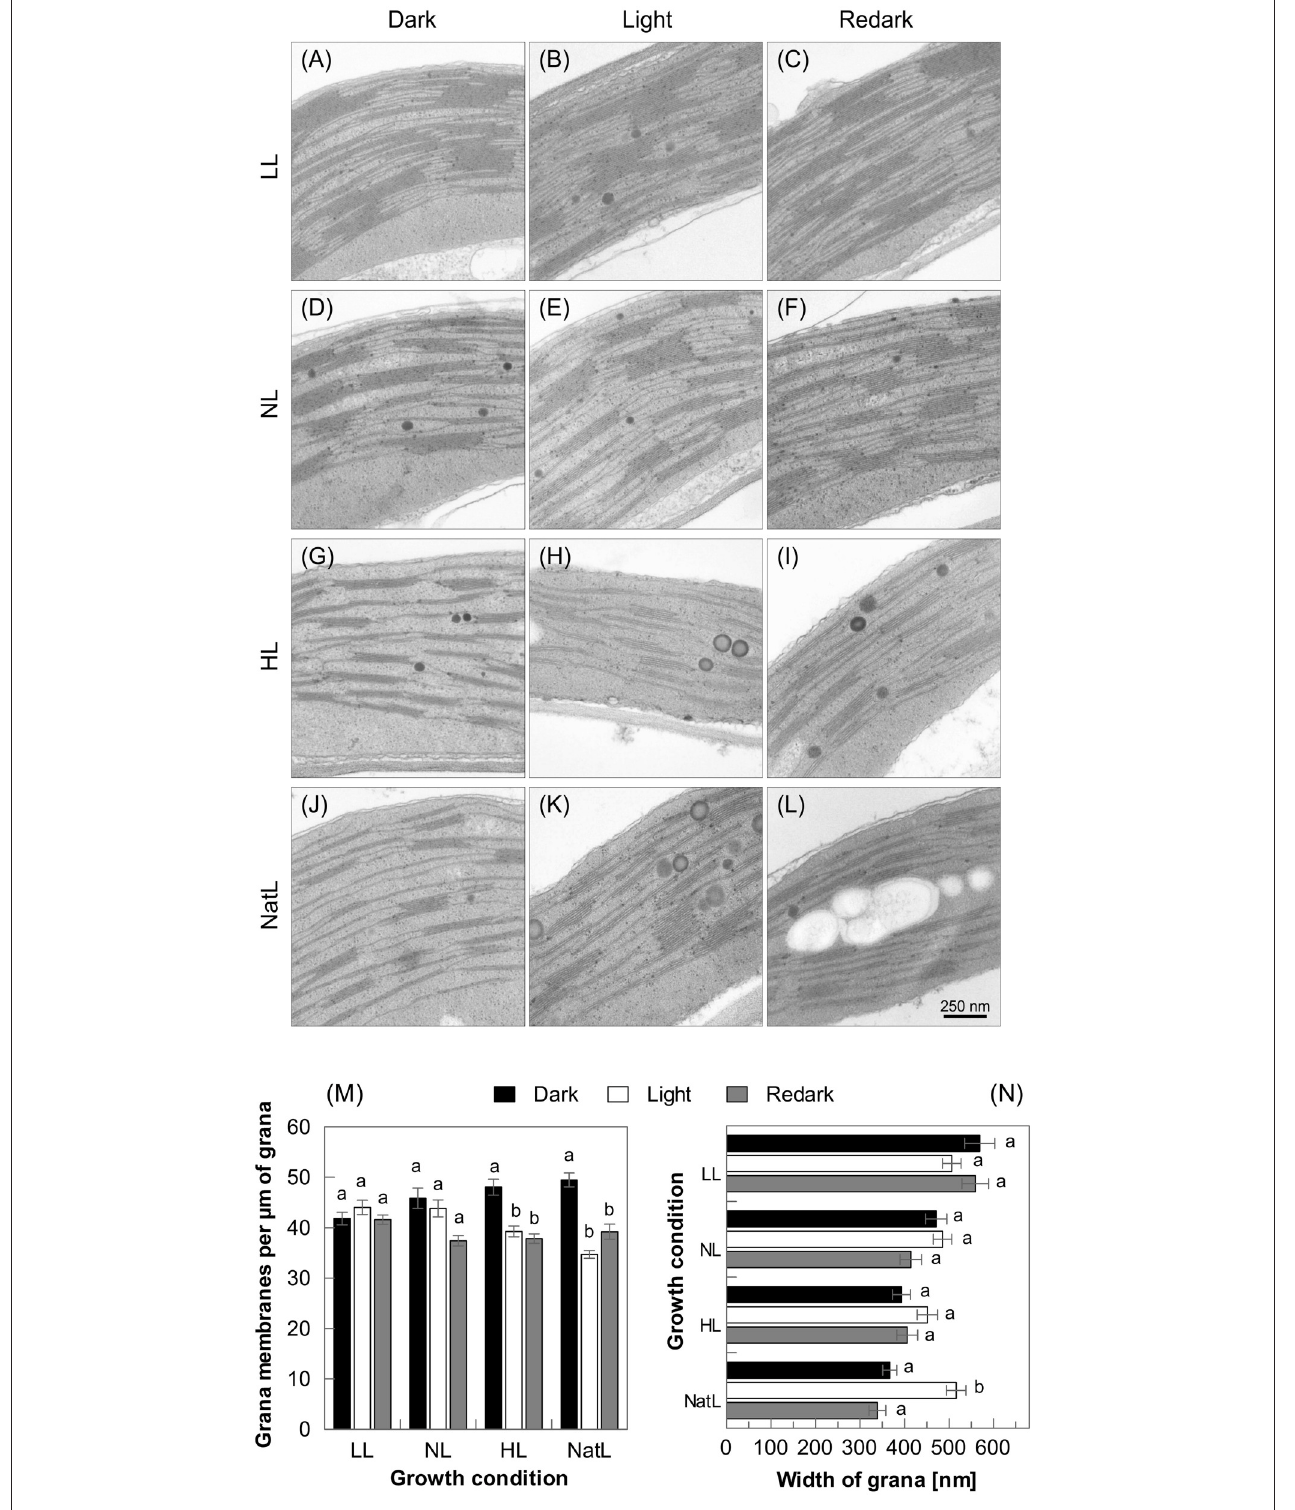
FIGURE 7 | Structural dynamics of thylakoid membrane stacking. Upper panel: Transmission electron microscopic images of thylakoid membranes of LL (A–C) , NL (D–F) , HL (G–I) , and NatL (J–L) plants in the dark- and light acclimated state, and after 10 min of re- darkening. Lower panel: Quantitative analysis of (M) grana height and (N) grana width. 16–20 images were analyzed for each condition. The light-adapted state was induced by 30 min illumination with white light at an intensity of 1000 µ mol photons m − 2 s − 1 . Significant differences (Holm-Sidak test, p < 0.05) as compared to the respective dark-acclimated state are indicated.